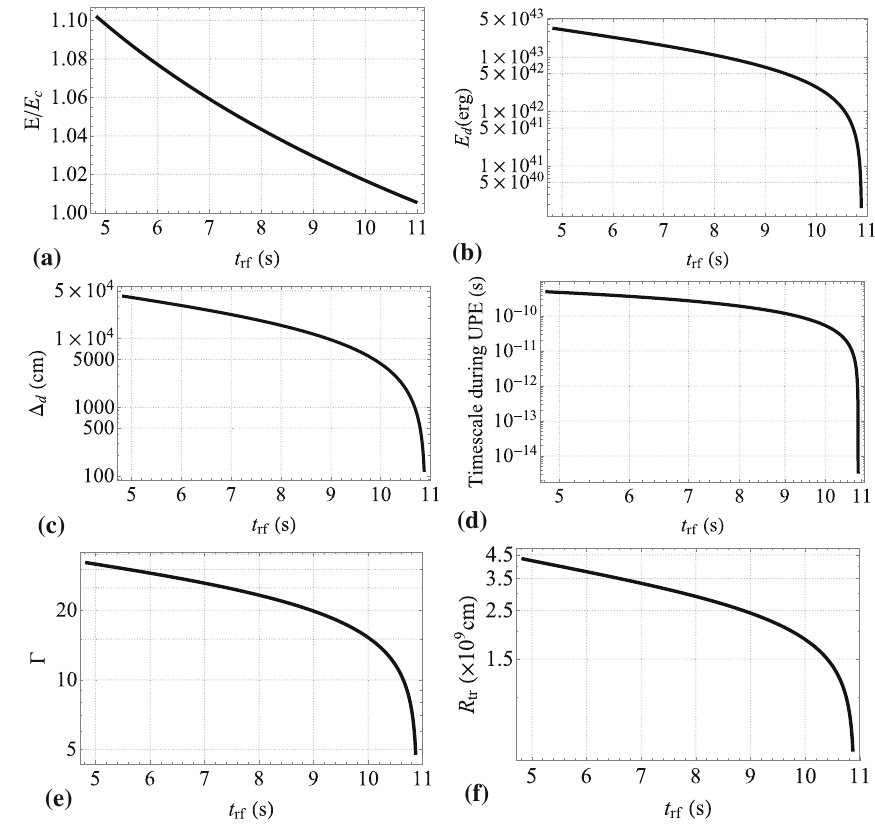
Table 3 The parameters of the inner engine and the transparency point, obtained from the starting time of the UPE phase for GRB 180720B